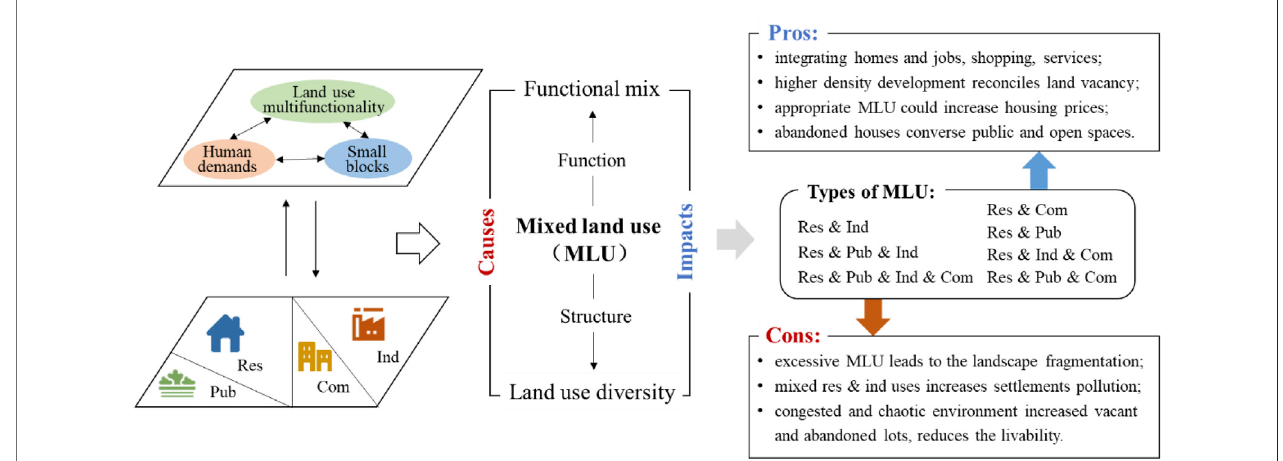
FIGURE 1 | Theoretical framework of MLU in rural communities. Notes: Res, Pub, Ind, and Com are abbreviations for residential land, public infrastructure land, industrial land, and commercial land, respectively.